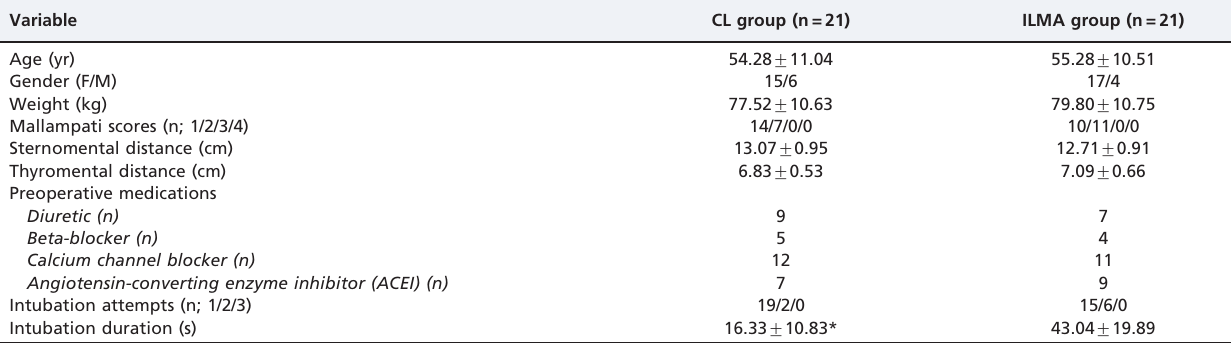
Table 1 - Demographic characteristics, airway assessments, and concurrent medications of the groups.